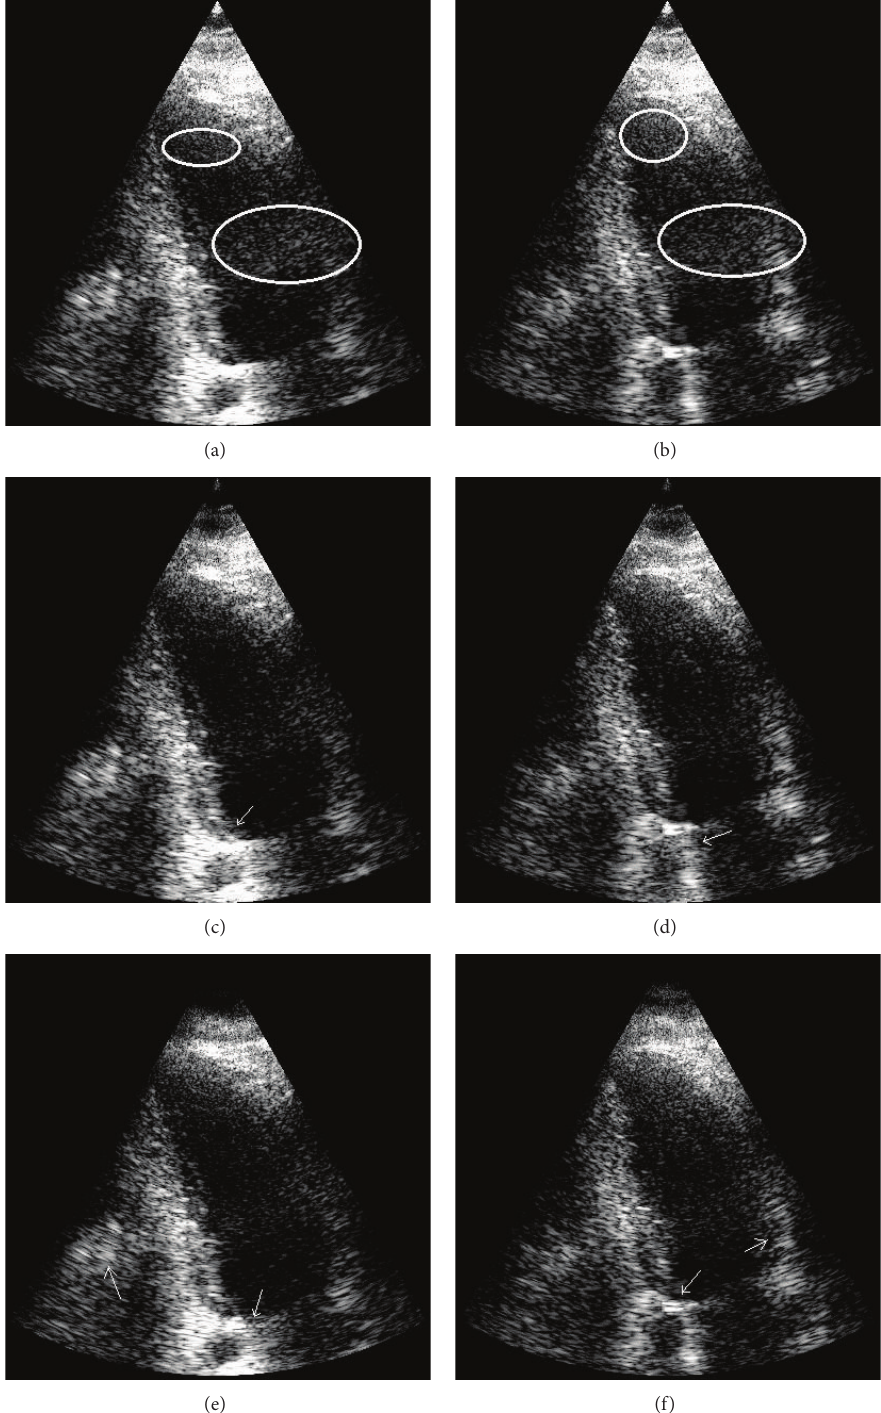
Figure 11: Two examples of an apical view of heart images are illustrated before clutter removal (a, b) and after clutter removal with MCA (c, d) and after applying SVF (e, f). Ellipses indicate regions of clutter artifacts due to multipath reverberations. The arrows point to regions of tissue incorrectly filtered. Images are shown on a log compressed linear gray scale mapping to 0 to